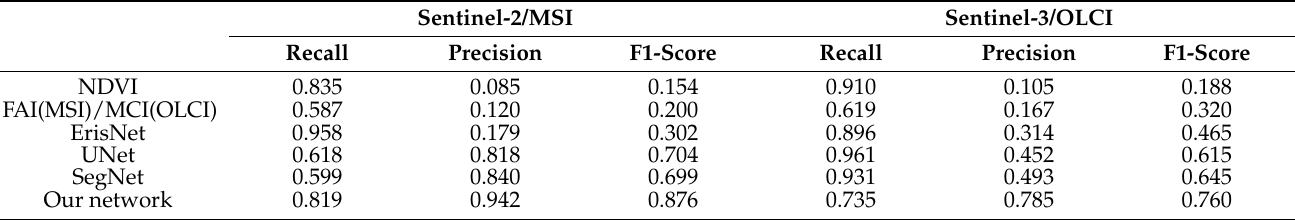
Table 4. Recall, precision and F1-score of each method (indexes and Neural Networks) for Sentinel- 2/MSI and Sentinel-3/OLCI. For Neural Network these metrics are calculated from the test data set (from the learning set of Tables S1 and